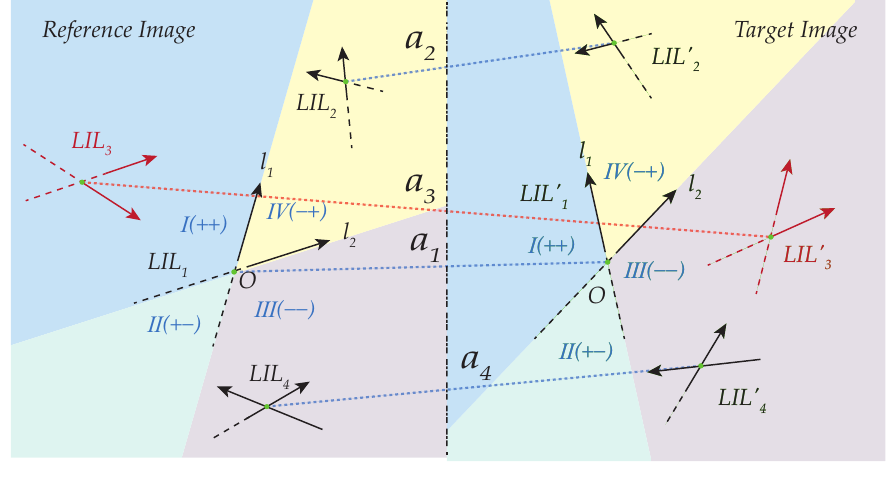
Figure 5. LIL spatial relations.